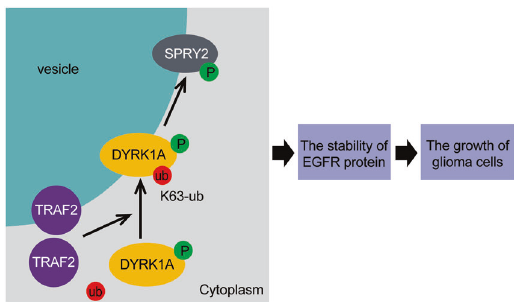
Fig. 7 Depletion of DYRK1A inhibits the growth of glioma cells mediated by TRAF2. A U251 cells were infected with lentivirus-expressing shRNAs targeting control or DYRK1A. After selection with puromycin for 5 days, cells were lysed and level of DYRK1A analyzed by western blotting. B U251 cells were incubated with 15 μ M INDY or 15 μ M Harmine, or were infected with shNC or shDYRK1A lentivirus and selected with puromycin. Cell proliferation of the treated U251 cells was measured ( n = 3 independent experiments). Data were shown as mean ± SD, * P < 0.05 and ** P < 0.01. C Colony-forming capacities of U251 cells treated as in B were measured (CFC, colony-forming cells). Representative images were shown (left) and the quanti fi cation of three independent experiments was plotted (right). Data were shown as mean ± SD, * P < 0.05 and ** P < 0.01. D The wound-healing assay was used to analyze the migration ability of U251 cells treated as in B . Left panel, representative images were shown. Right panel, the quanti fi cation of three independent experiments was plotted. Data were shown as mean ± SD, * P < 0.05 and ** P < 0.01, scale bar = 500 μ m. E A172 cells were infected with lentivirus-expressing control, HA-TRAF2 and/or DYRK1A shRNAs. Cell proliferation of the A172 cells was measured (n = 3 independent experiments). Data were shown as mean ± SD, * P < 0.05 and ** P < 0.01. F The wound-healing assay was used to analyze the migration ability of the treated A172 cells treated as in E . Representative images were shown (left) and the quanti fi cation of three independent experiments was plotted (right). Data were shown as mean ± SD, * P < 0.05 and ** P < 0.01, scale bar = 500 μ m.